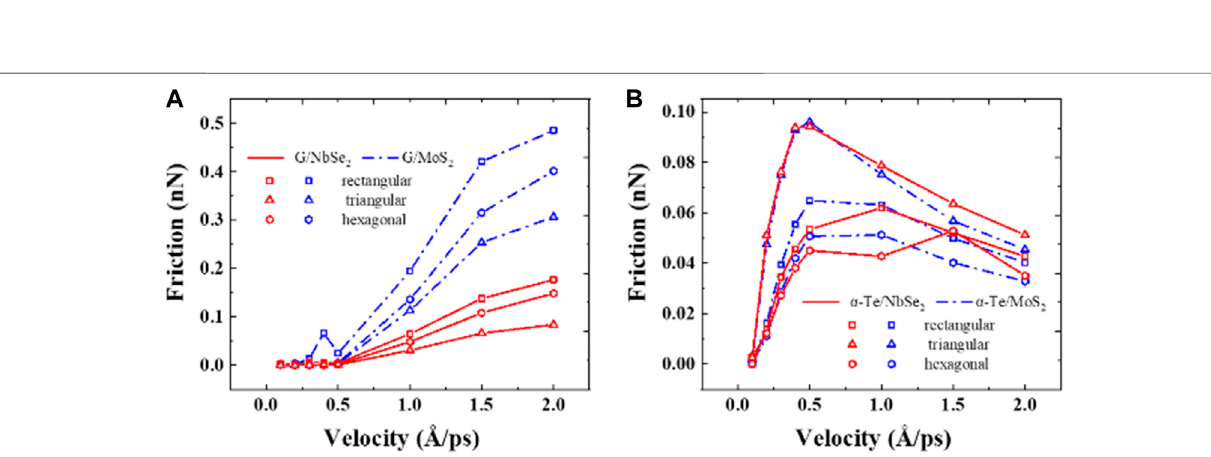
Frontiers in Mechanical Engineering |